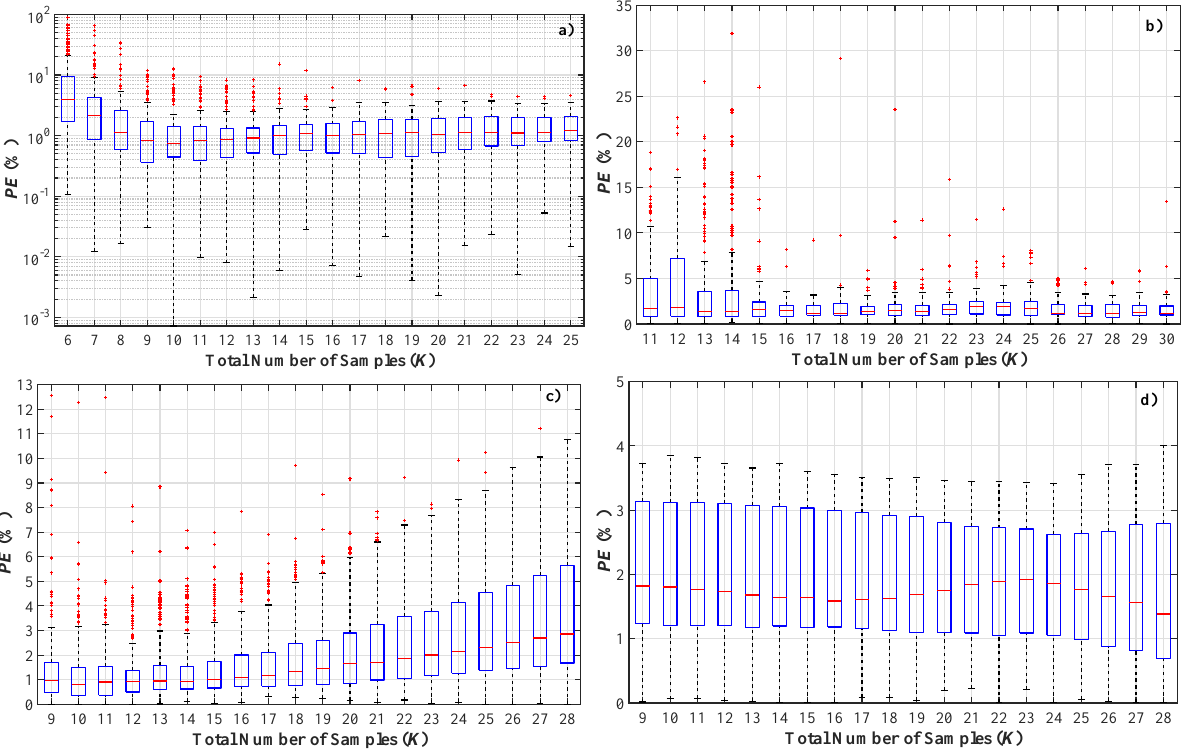
Figure 10. Probabilistic assessment by means of boxplots. ( a ) Method #1, ( b ) Method #2, ( c ) Method #3, and ( d ) Method